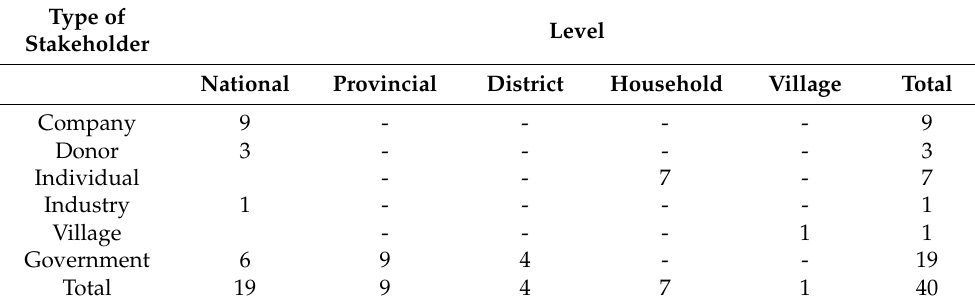
Table 2. Stakeholder